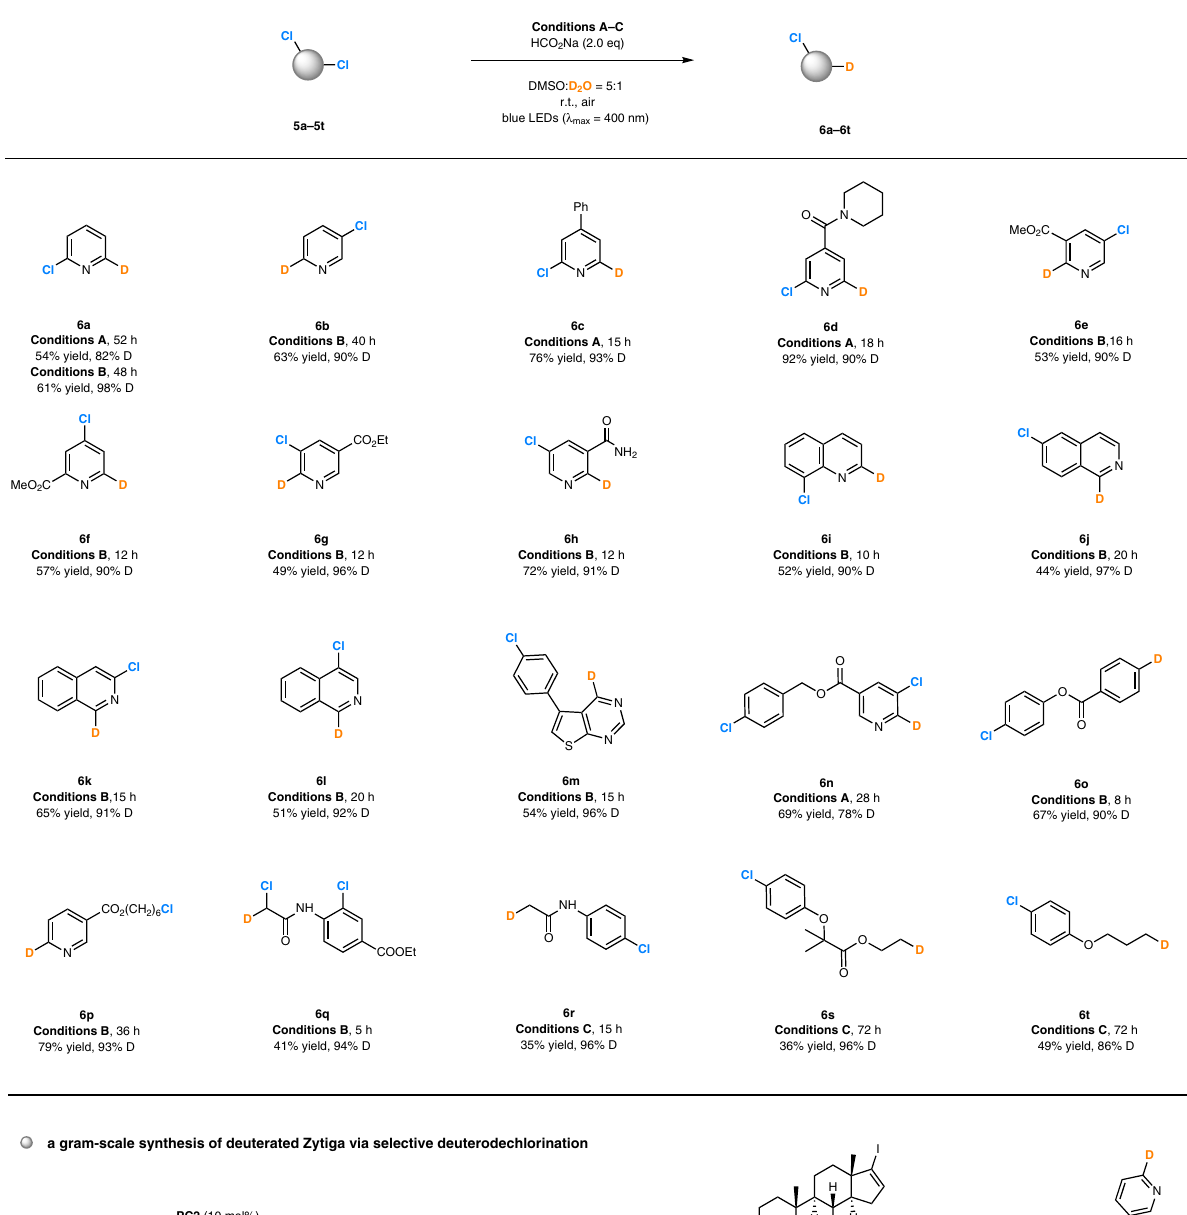
a gram-scale synthesis of deuterated Zytiga via selective deuterodechlorination